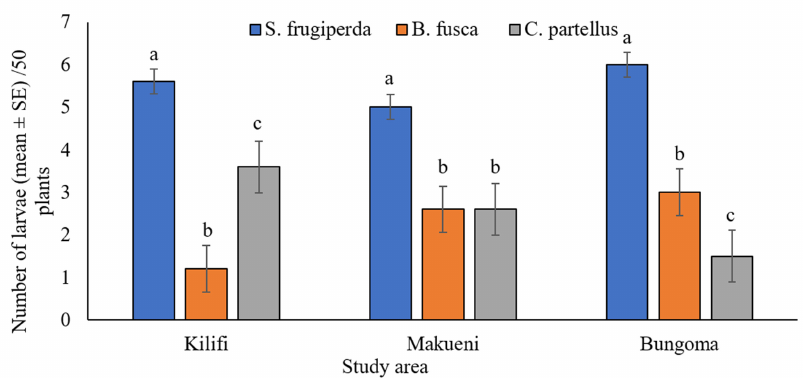
Figure 5. Total number (mean ± SE) of Spodoptera frugiperda , Busseola fusca , and Chilo partellus larvae found infesting maize fields across three agroecological zones in Kenya. Different lowercase letters above error bars reflect significant differences in the number of larvae of lepidopteran species per 50 maize plants in the study